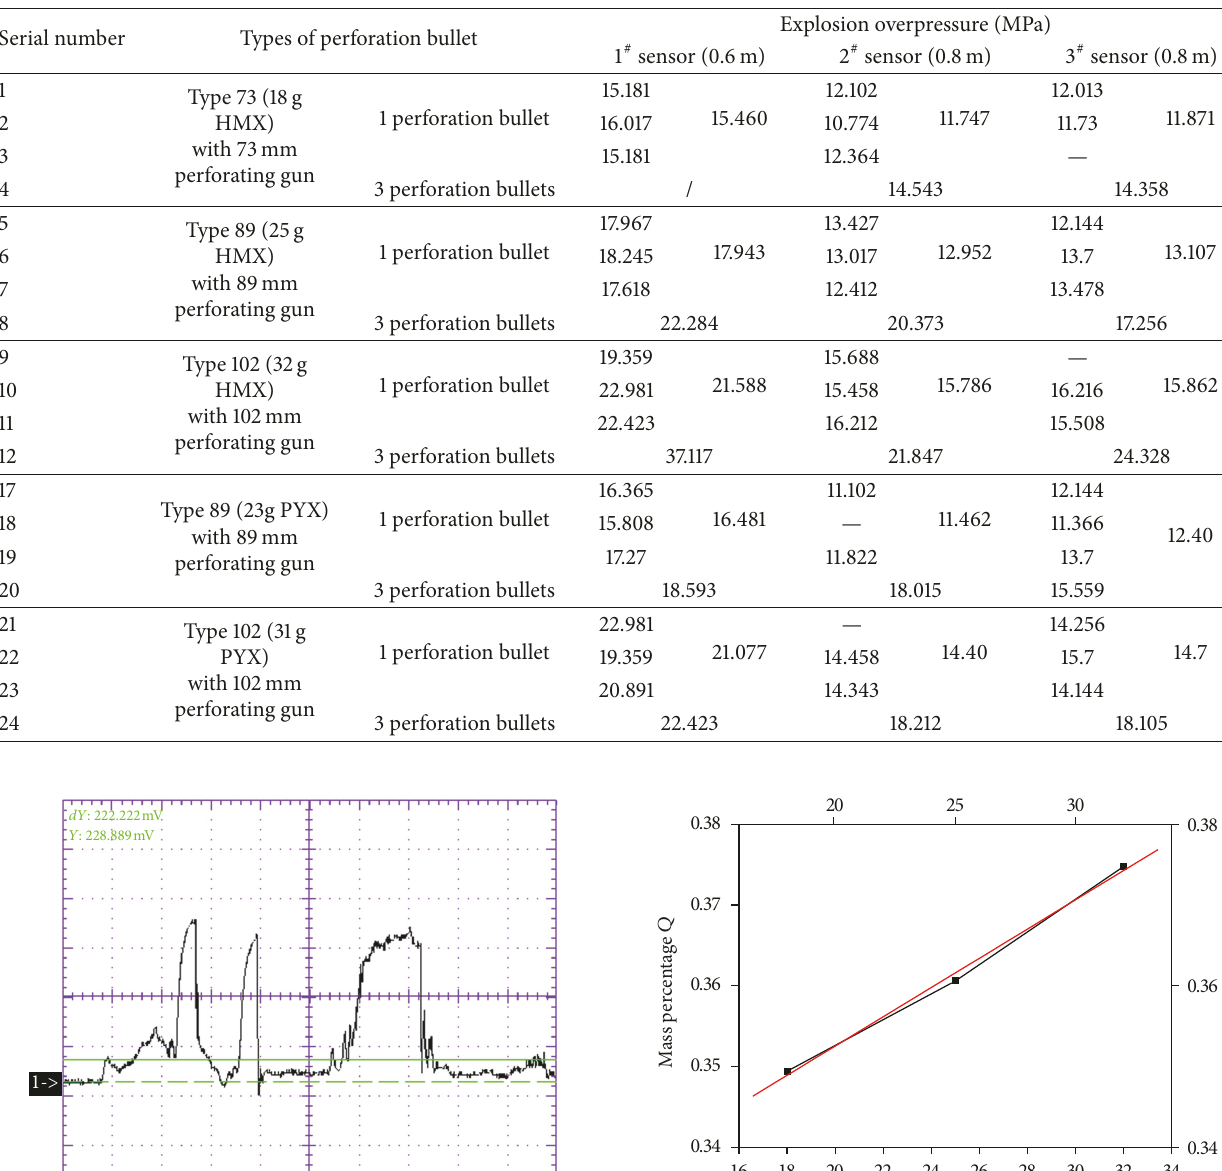
Table 2: Explosion overpressure values of perforation bullet measured in the experiment.